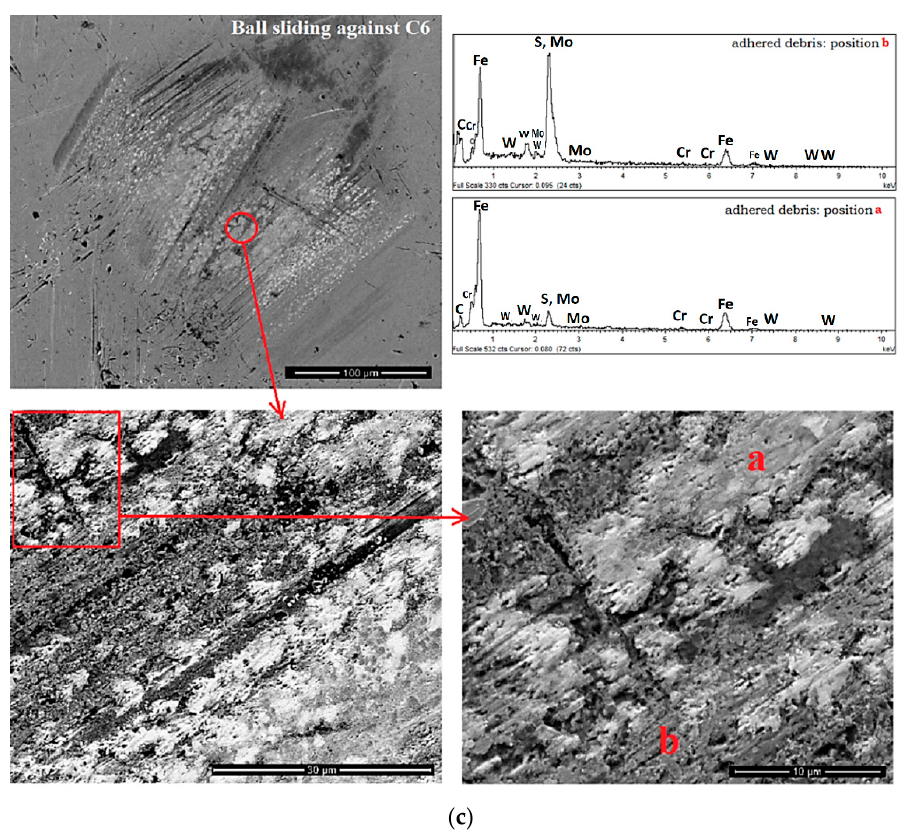
Figure 9. SEM images (taken at both low and high magnifications) of the tribolayer adhered to the steel counterpart and related EDX analysis on the debris positions ‘a’ and ‘b’ after lubricated sliding against ( a ) C2, ( b ) C4 and ( c ) C6 at 200 °C .